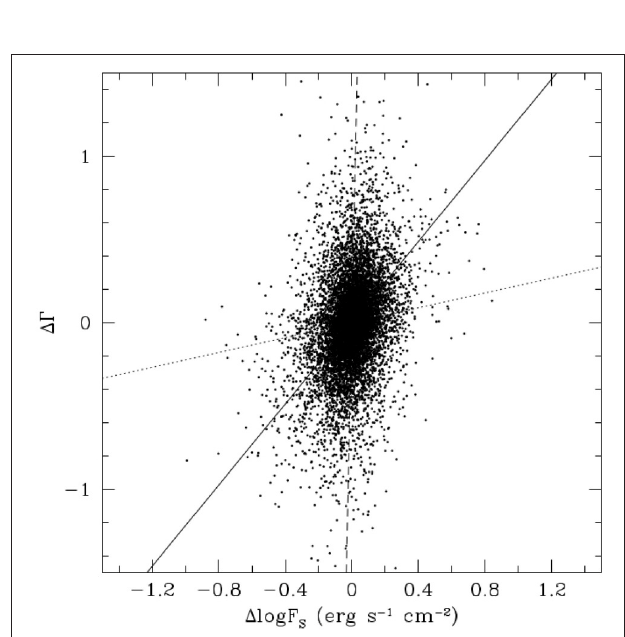
FIGURE 2 | The ensemble correlation between the variations of the photon index 1Ŵ and the variations of the logarithmic flux 1 log F are shown. The dotted line represents β xy , the dashed line represents β yx , while the bisector β bis is shown as a continuous